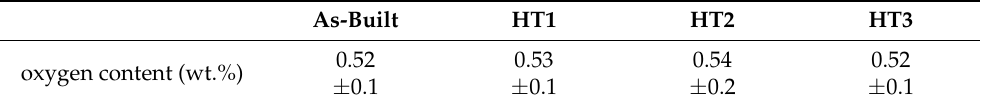
Figure 8. ( a ) TEM image of NiTi matrix with Ni 2 Ti 4 O particles; ( b ) SAED of Ni 2 Ti 4 O in the orientation [013] (an area marked by a red circle). Table 3. Oxygen content in as-built and HT1-HT3 samples. As-Built HT1 HT2 HT3 oxygen content (wt.%)